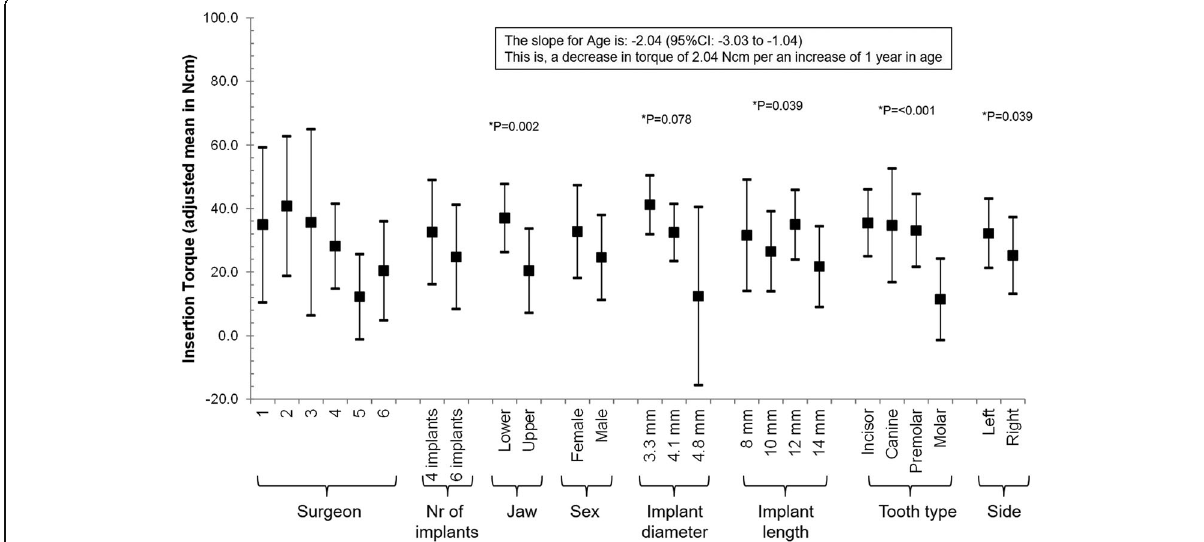
Fig. 6 Multivariable association between insertion torque and all considered risk factors, including Age as a risk factor. A mixed regression model was used. The effect of the patient was introduced in the model as a random